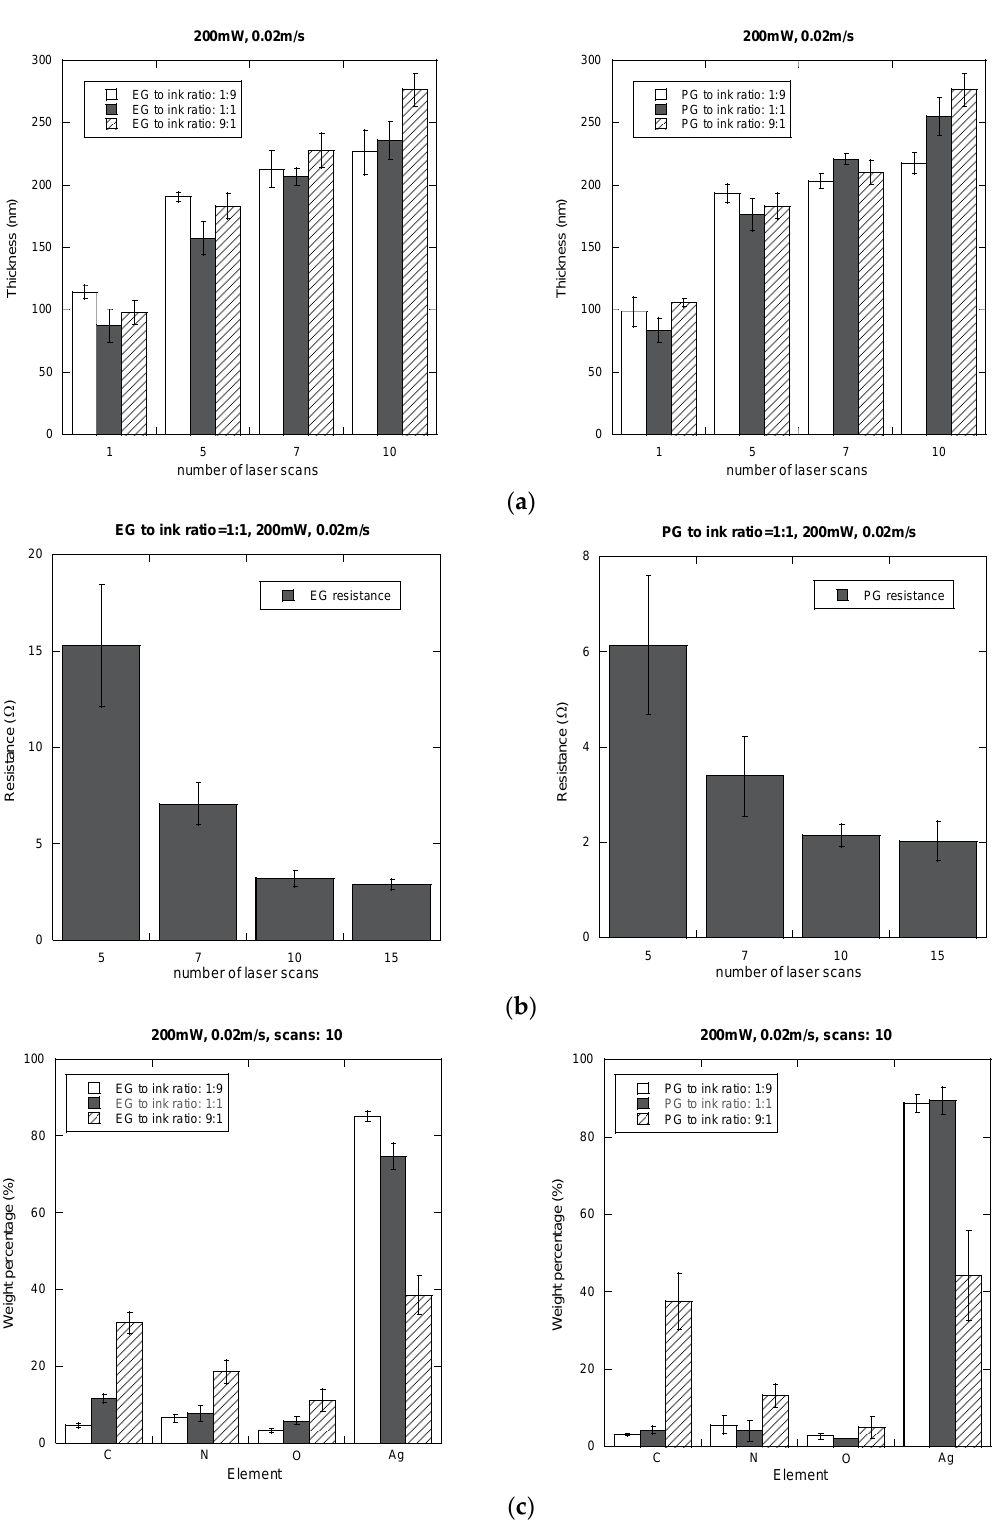
Figure 5. ( a ) Thickness and ( b ) Electrical resistance of the silver films with respect to the number of laser scans; ( c ) EDS results for the silver lines with 10